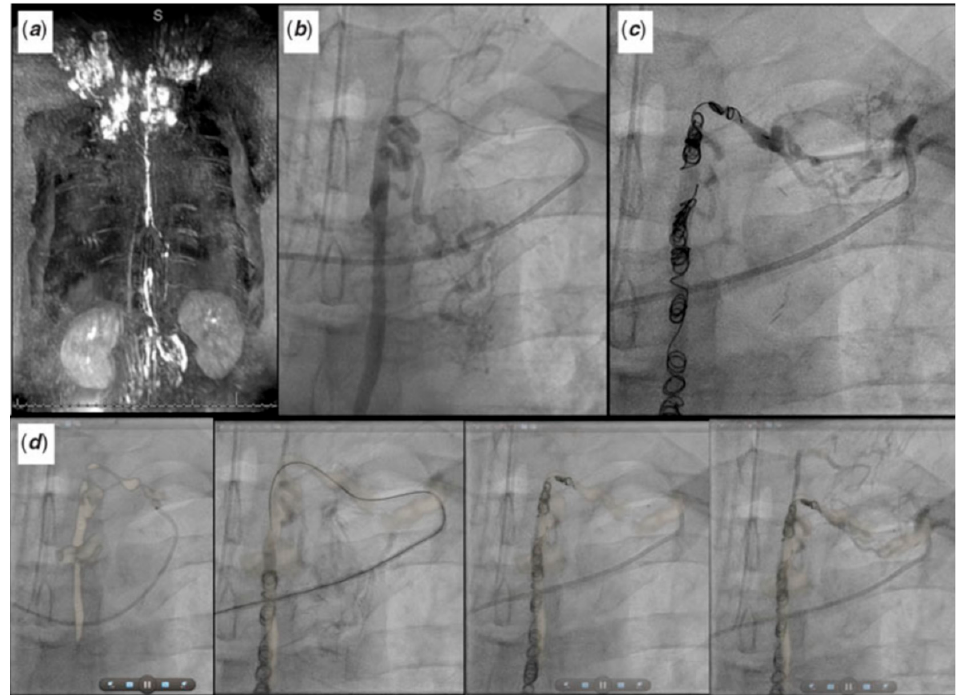
Figure 18. Symptomatic Fontan patient with severe lymphatic insufficiency presents following a dynamic contrast magnetic resonance lymphangiogram ( a ) for fluoroscopic overlay guided retrograde lymphatic embolization ( b – d ) via the thoracic duct. Revised from ref [9] .